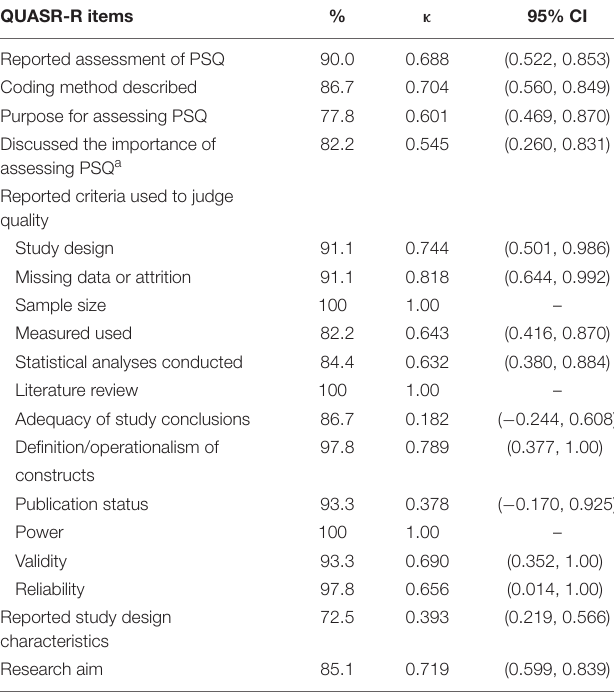
TABLE 1 | Inter-rater reliability for the QUASR-R